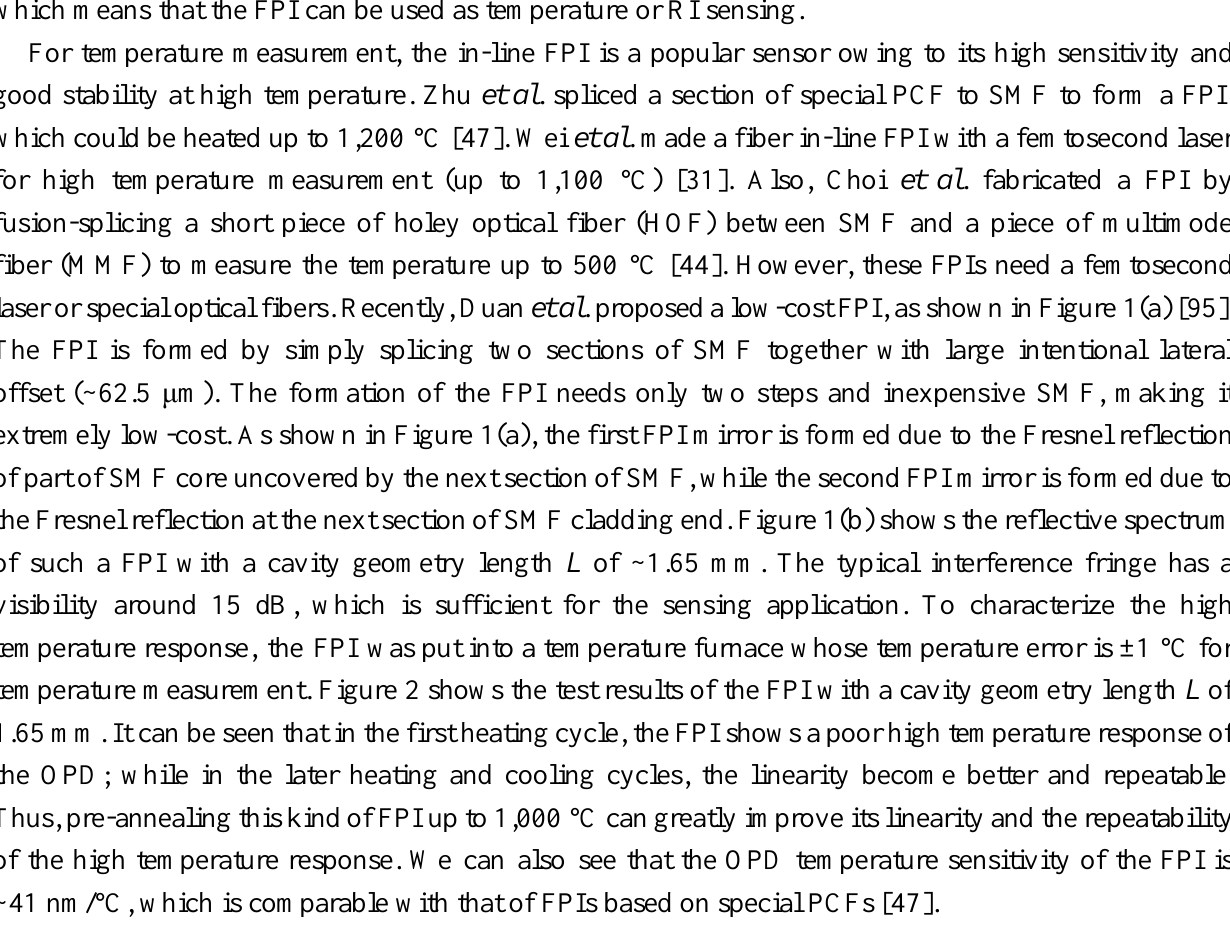
Figure 1. The FPI based on large lateral offset: ( a ) schematic, inset picture is the microscope photograph; ( b ) reflection